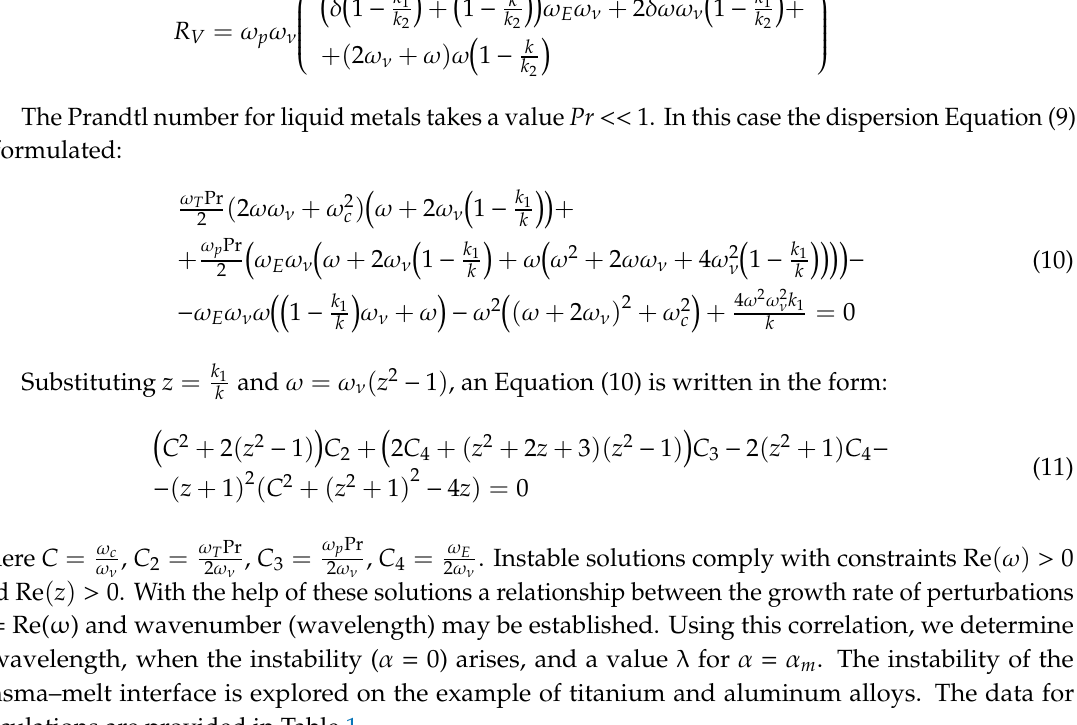
Table 1. Thermal physical properties of systems Ti-Y and Al-Si-Y [28–30]. Symbol / Dimension Ti-Y Al-Si-Y Property